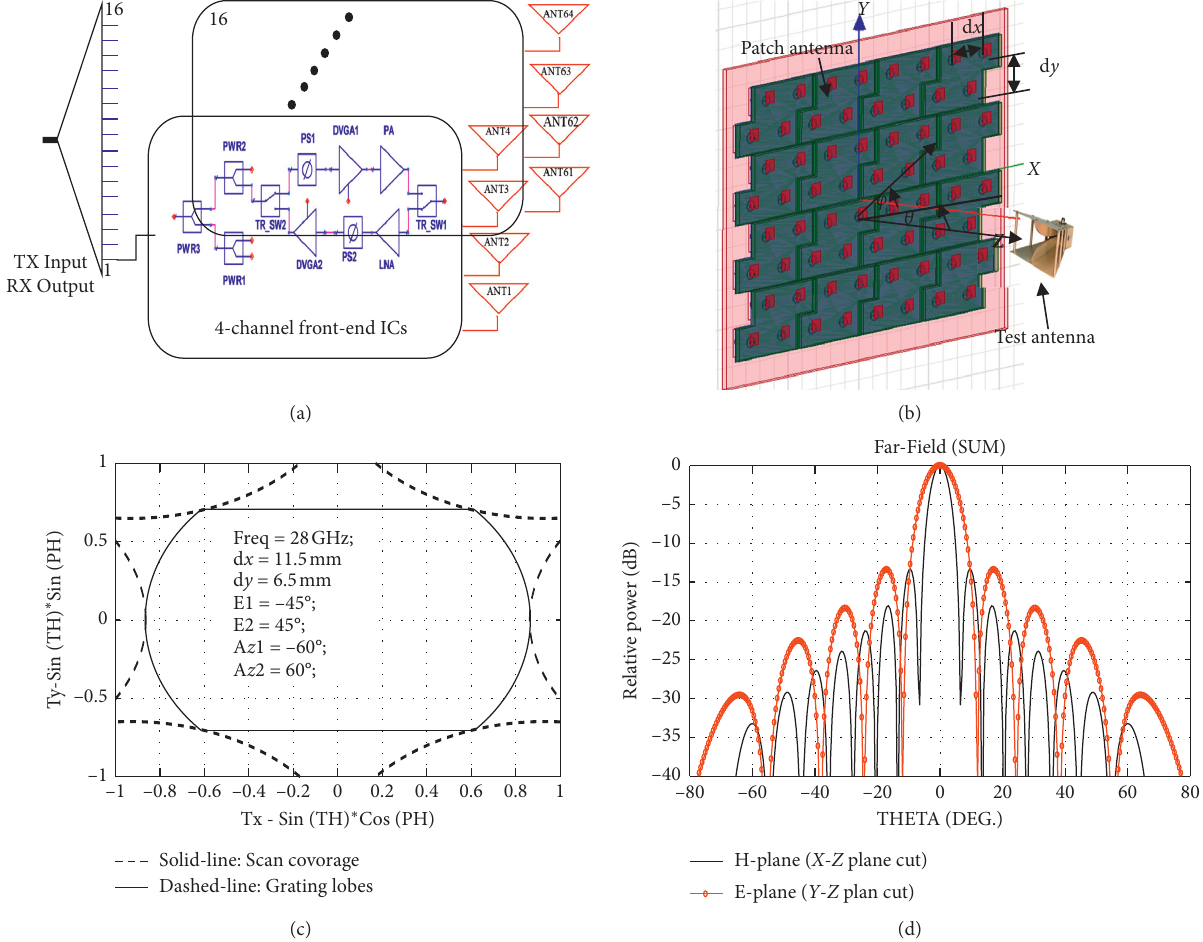
Figure 1: (a) Schematic of mm-wave active massive MIMO system; (b) 8 × 8 element microstrip array (d x � 11.5mm, d y � 6.5 mm) associated with a test antenna in the far-field range for calibration; (c) grating lobe diagram analysis (solid line: scan volume, dashed line: grating lobes) of the array with a triangular array lattice of d x � 11.5mm and d y � 6.5mm; (d) two-dimensional far-field patterns (E-H